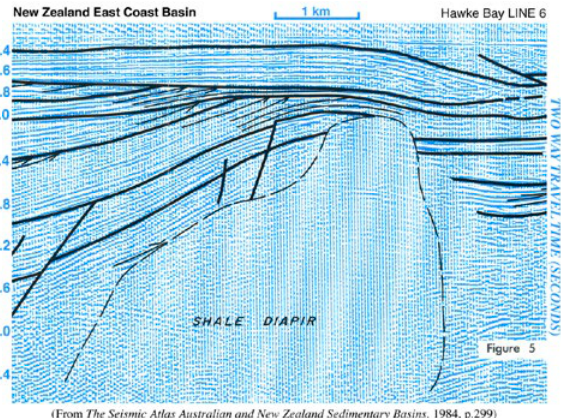
Figure 37. Seismic surveys 15 record a large intrusive shale mass in Hawks Bay, New